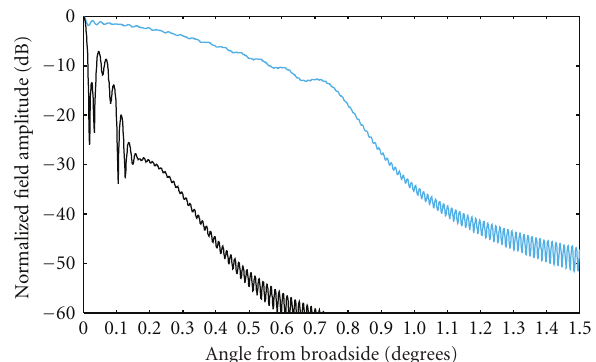
Figure 1: Comparison between simulated Near-Field pattern at the distance of 2160 m (blue line), and Near-Field pattern, at the distance of 2160 m, with an axial displacement of the feed Δ f = 301 mm (black